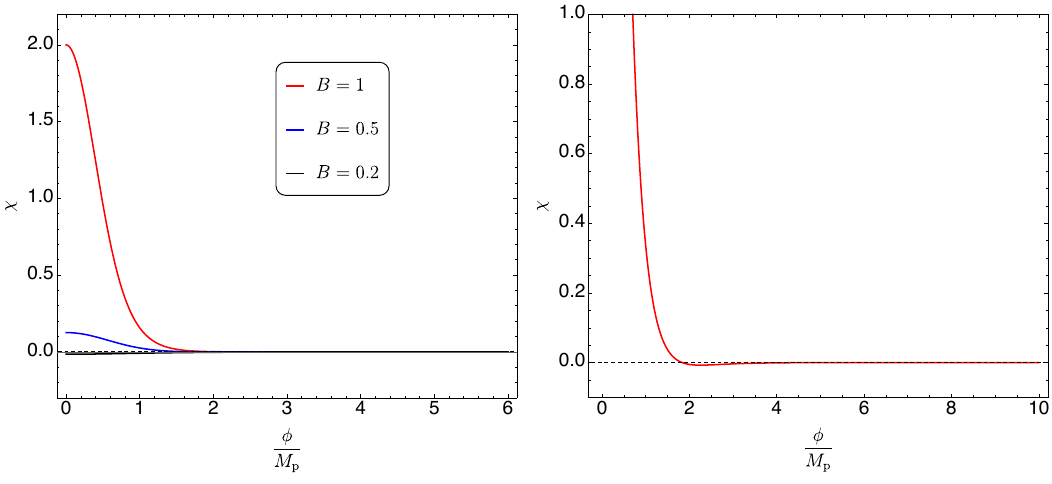
Figure 3 . a) The value of (cid:31) for A = 1 and B = 0 : 2 ; 0 : 5 ; 1 : 0. The SSWGC implies (cid:31) (cid:21) 0. b) The value of (cid:31) for the Starobinsky